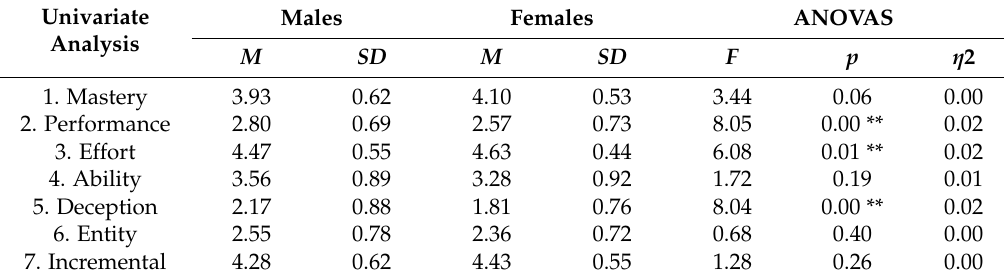
Table 2. Univariate analysis of the variance for gender as a function of the perceived motivational climate, the beliefs of the causes of success in sport and the perception of ability. Univariate